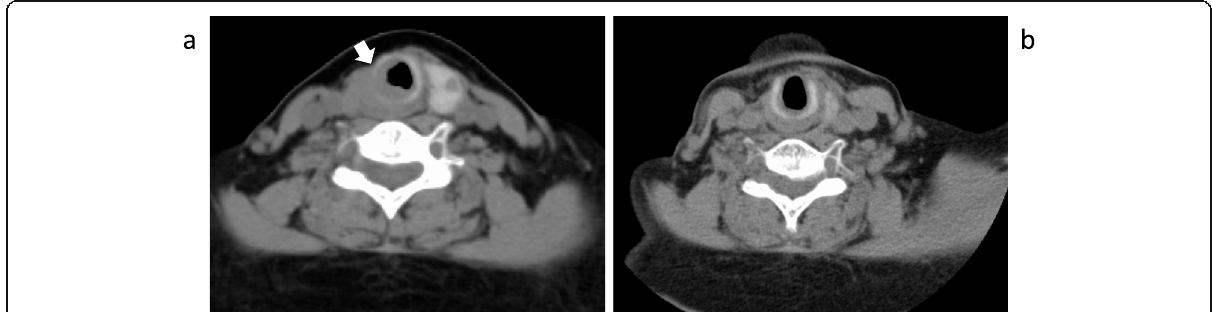
Fig. 8 CT findings before and after radiation. a Stenosis of the trachea occurred due to recurrent tumor invasion (arrow). b The recurrent tumor could not be recognized 1 year after radiation therapy.